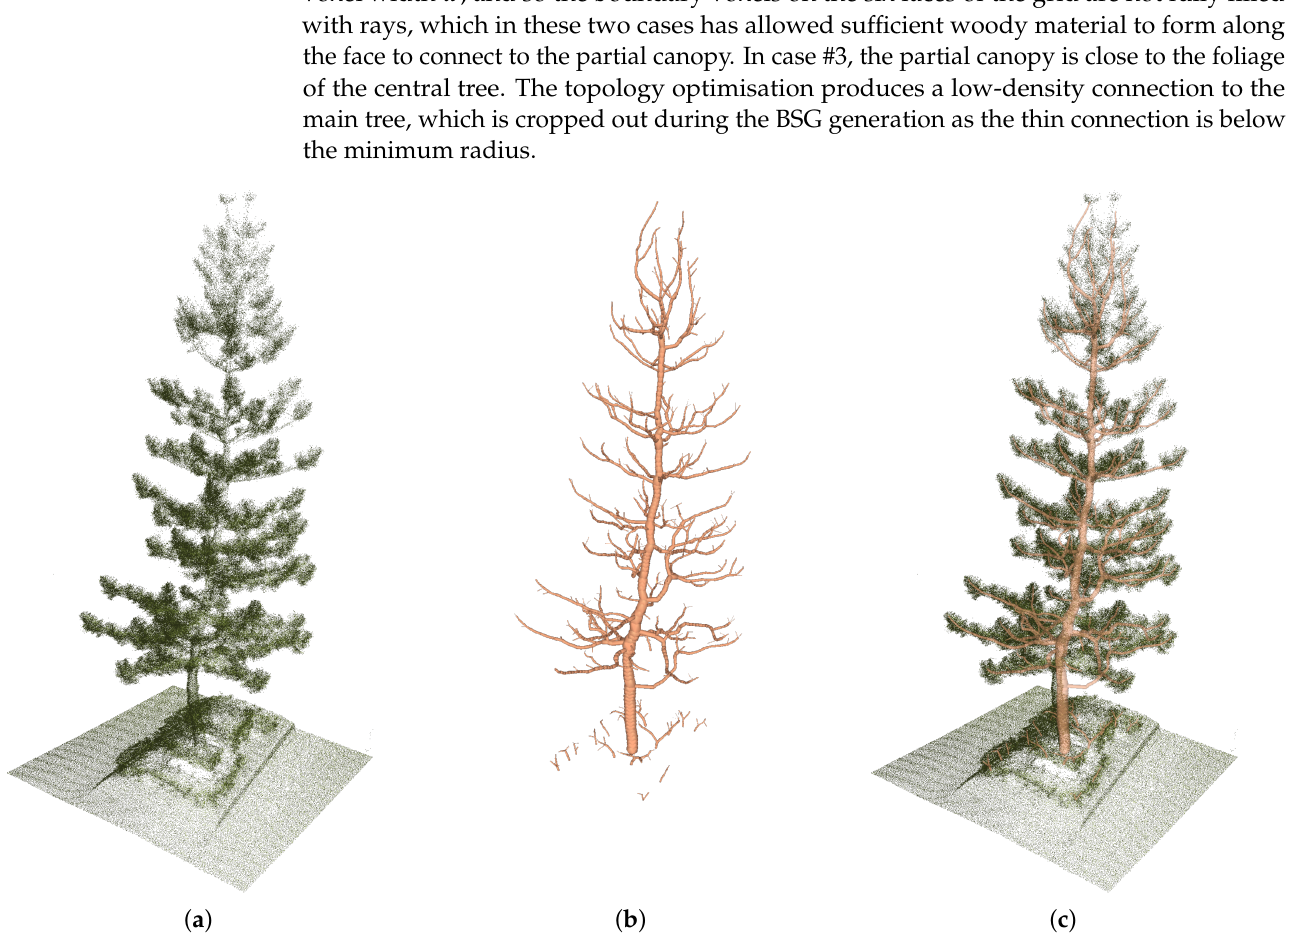
Figure 6. Enlarged view of lone pine tree (case #1). ( a ) Closeup view of point cloud ( b ) Reconstructed BSG ( c ) Overlaid view of BSG on point